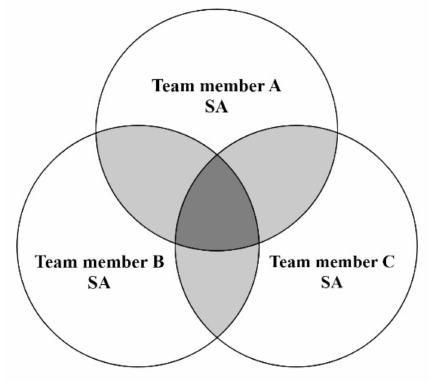
Figure 1. Team situation awareness model from